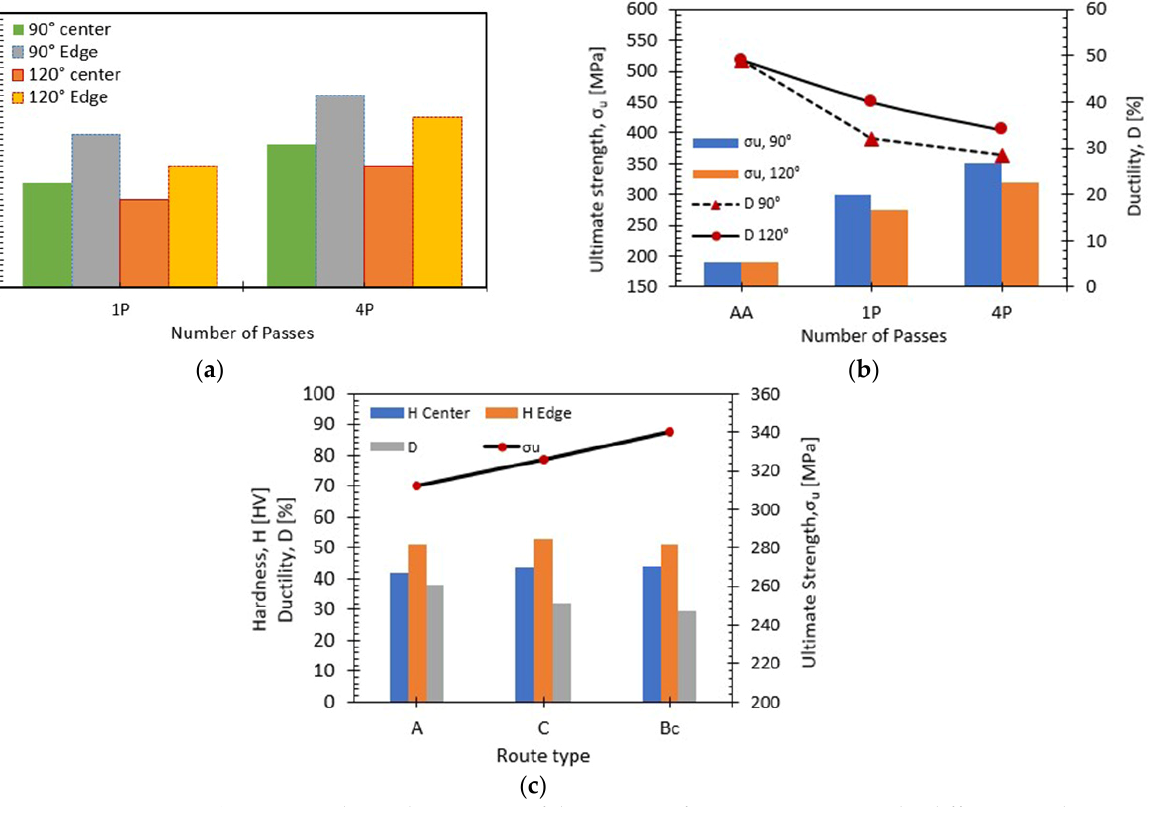
Figure 6. Mechanical properties of the AA-Mg after ECAP process at the different conditions; effect of number of passes and die angle using route Bc ( a , b ), and effect different routes, A, C and Bc using ϕ = 90° for two passes ( c ).